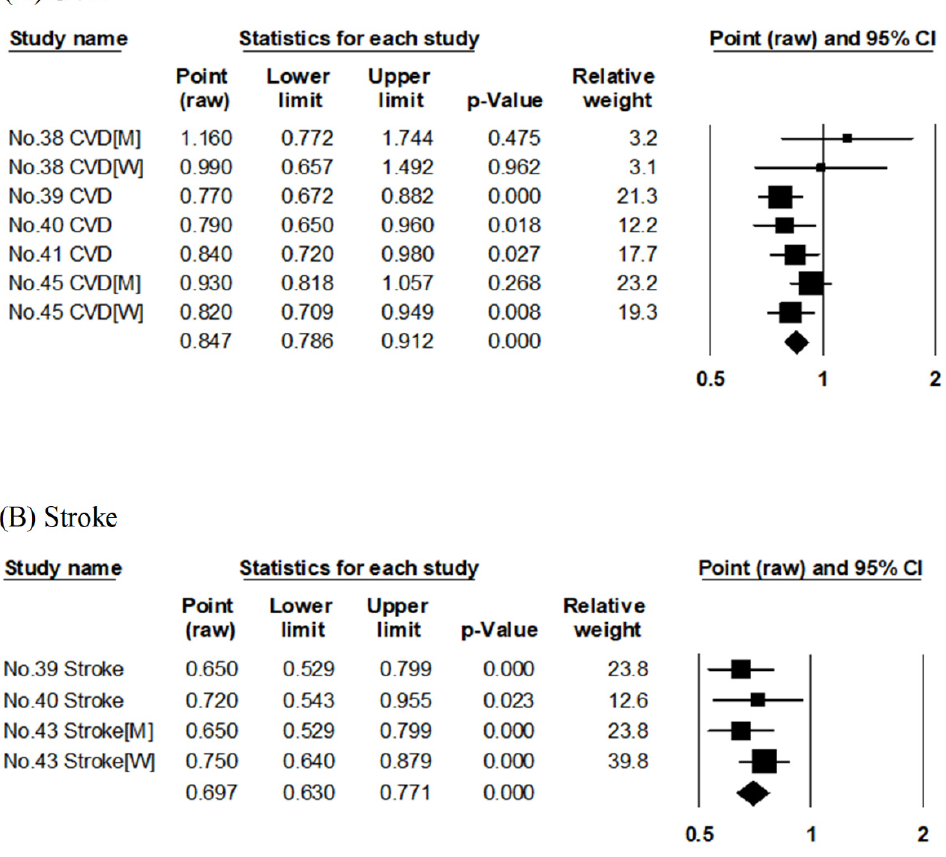
Figure 4. Meta-analysis of fruit consumption and mortality risk. ( A , B ) show the association between fruit consumption and CVD and stroke mortality risk, respectively. The area of each square is proportional to the study weight. Horizontal lines represent 95% confidence intervals. Diamonds rep- resent pooled estimates from inverse-variance-weighted random-effects model. The number given in the study name indicates that of the cited reference [38–41,43,45]. CVD; cardiovascular disease.